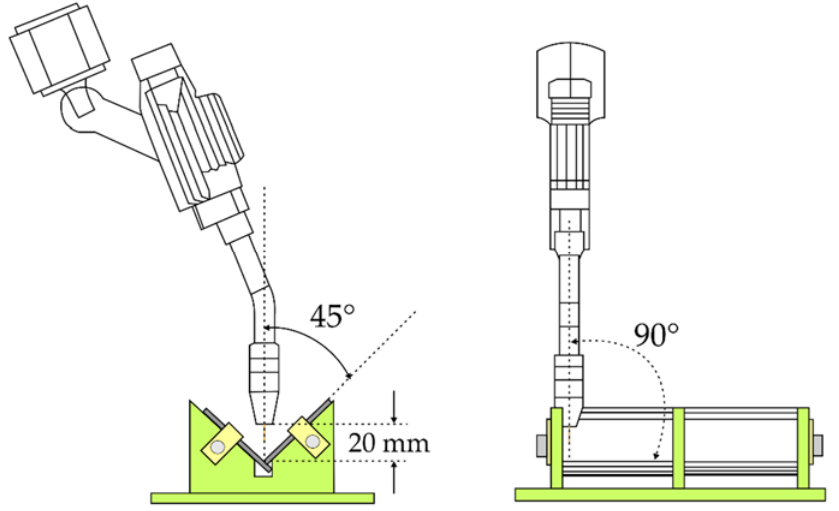
Figure 2. The position of the welding torch in relation to the axis of the weld bead.